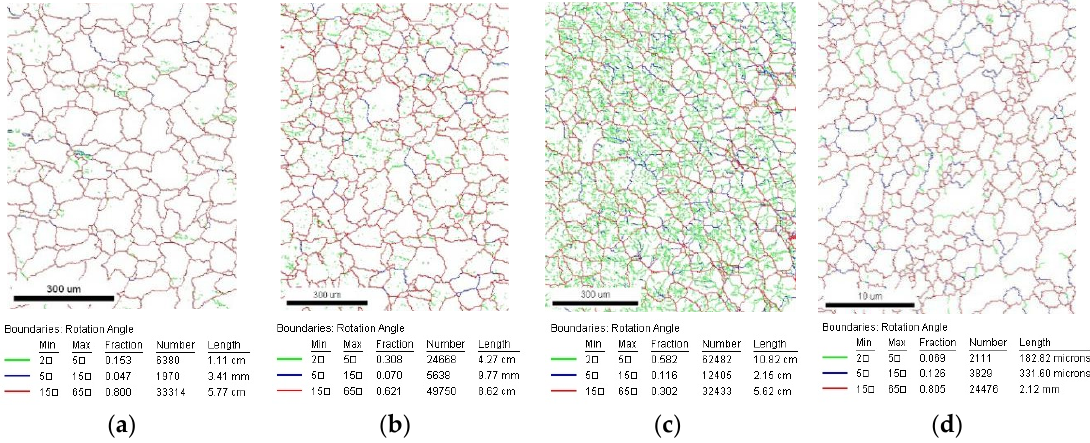
Figure 4. Grain boundary orientation angle distributions of ( a ) base material (BM), ( b ) heat affected zone (HAZ), ( c ) thermo-mechanically affected zone (TMAZ), and ( d ) welded nugget zone (WNZ) in the FSW joint.